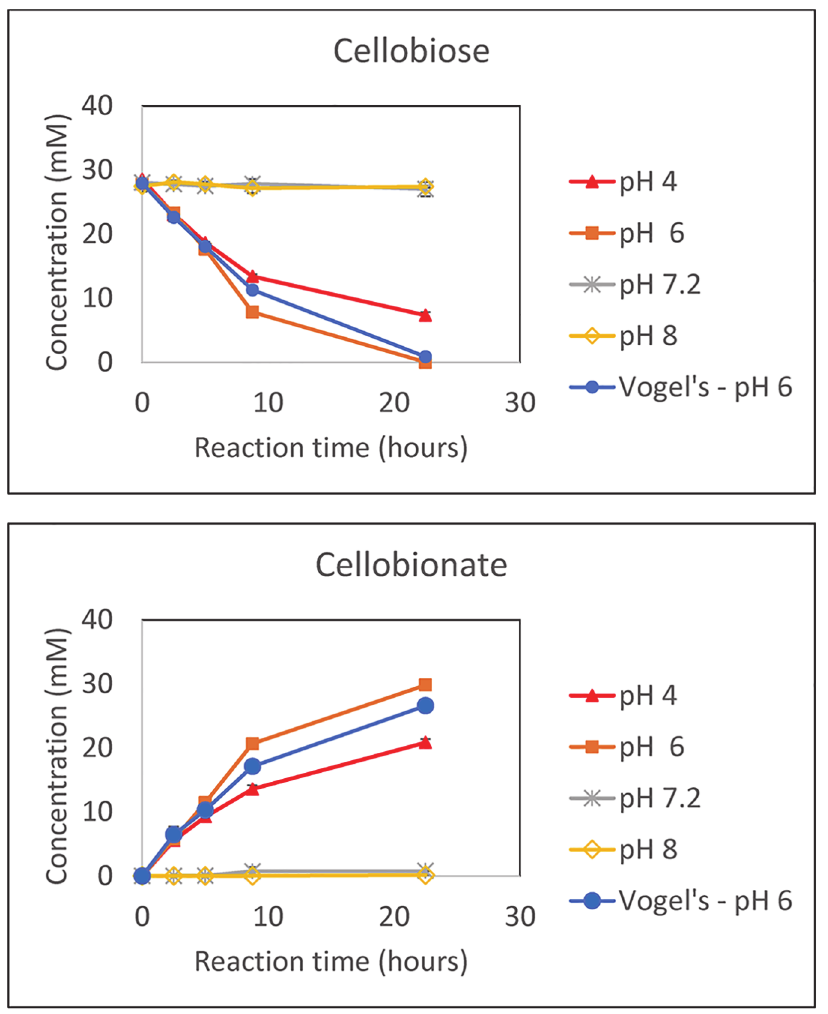
Fig 2. pH effect on the conversion of cellobiose to CBA via CDH-ABTS-laccase mediated conversion. Acidic conditions (pH 4 and pH 6) used 50 mM sodium citrate buffer; pH 7.2 and pH 8 used 50 mM sodium phosphate buffer. The Vogels pH 6 condition used 1x Vogel ’ s salts medium. The results shown are the means of biological duplicates with the error bars representing the standard deviation.